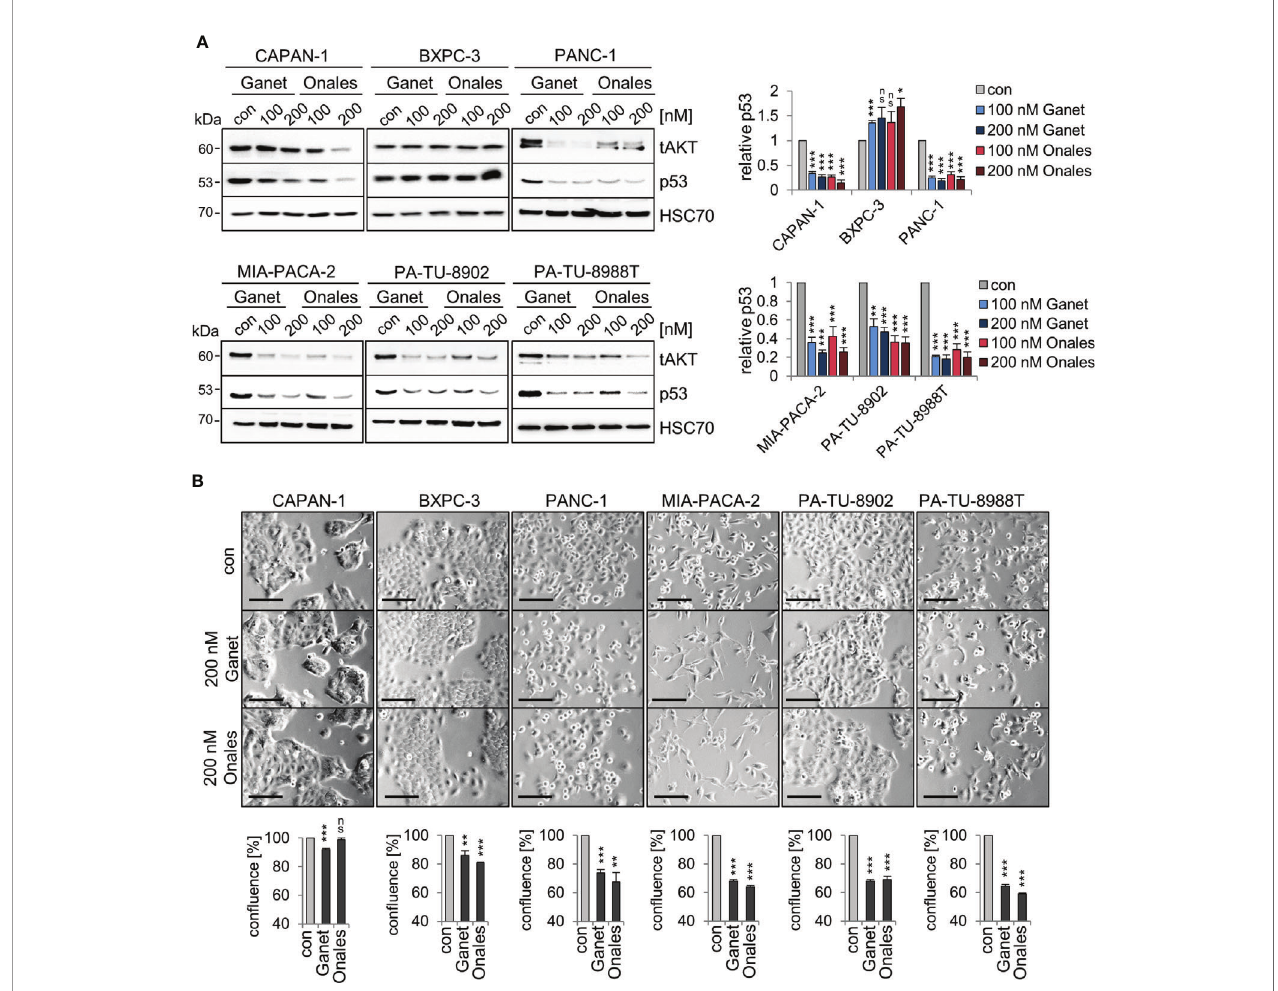
FIGURE 2 | Missense p53 mutants in PDAC cells are stabilized by Hsp90. (A) Hsp90-dependent aberrant stabilization of mutp53 proteins in PDAC cell lines. Cells were treated for 24 h with the indicated concentrations of Ganetespib, Onalespib, or DMSO. One representative immunoblot out of three each is presented. HSC70, loading control. Total AKT ( ‘ tAKT ’ , AKT serine/threonine kinase 1) as well-known Hsp90 client serves as functional control for an Hsp90 inhibition. (right) Diagrams represent the means ± SEM of densitometric quanti fi cations of at least two independent experiments with technical replicates (total n ≥ 3 immunoblots), normalized to HSC70. Calculated relative to control DMSO treatments (con). (B) Cell con fl uence determination. Representative images of cells after treatment with 200 nM Ganetespib, Onalespib, or solvent control for 24 h. Cell con fl uency was analyzed using a Celigo imaging cytometer. Scale bars, 100 µm. Con fl uence was calculated relative to their respective DMSO control from n = 3 biological replicates. (A, B) Student ’ s t test. *p ≤ 0.05; **p ≤ 0.01; ***p ≤ 0.001; ns, not signi fi